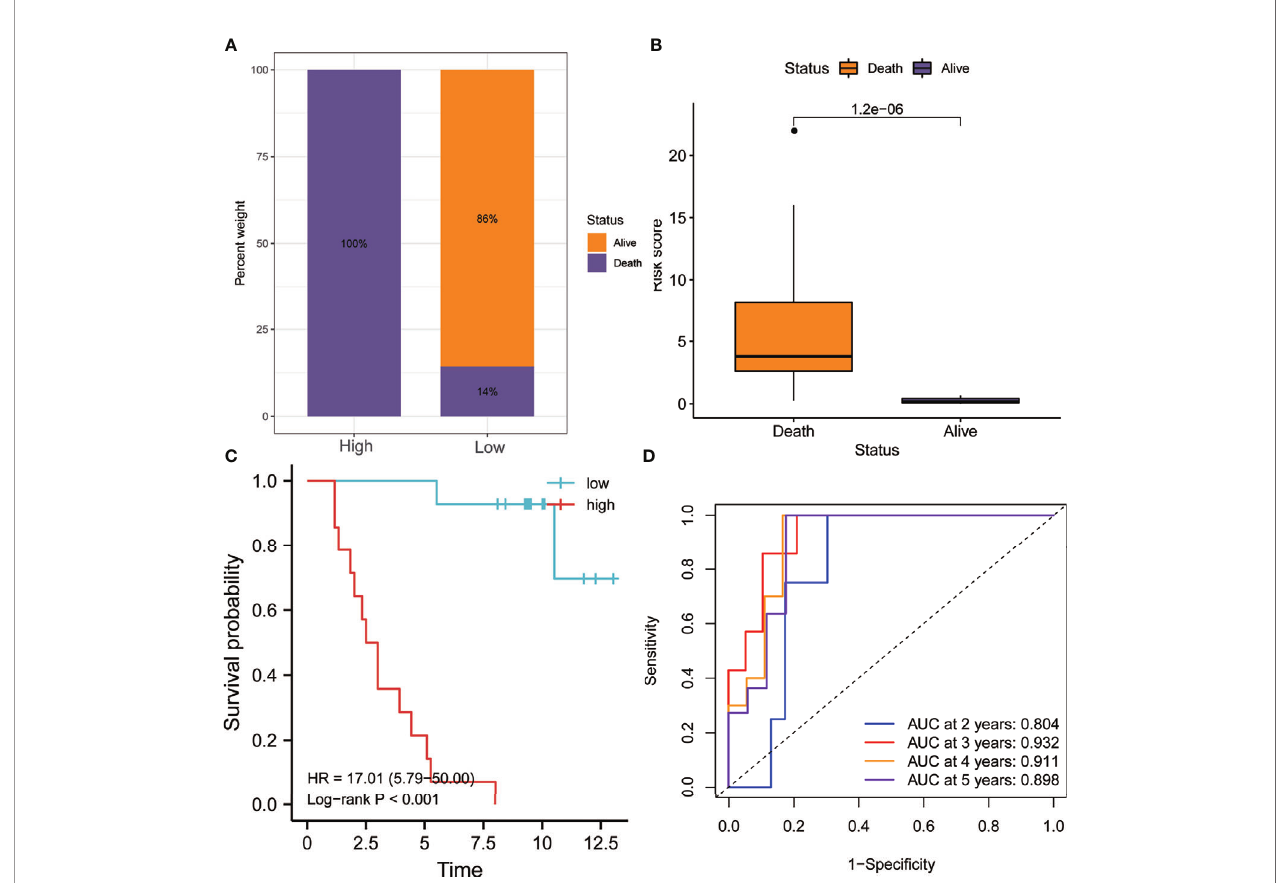
FIGURE 7 | Validation of the risk model in the GSE84976 dataset. (A) Patients in the high-risk group had higher mortality rates. (B) The risk scores of patients who died during follow-up were higher. (C) Kaplan – Meier analysis showed that patients with higher risk scores had worse overall survival. (D) The receiver operating characteristic (ROC) curve showed good predictive accuracy of the risk score for OS (AUC > 0.8). AUC , area under the ROC curve; HR , hazard ratio; OS , overall